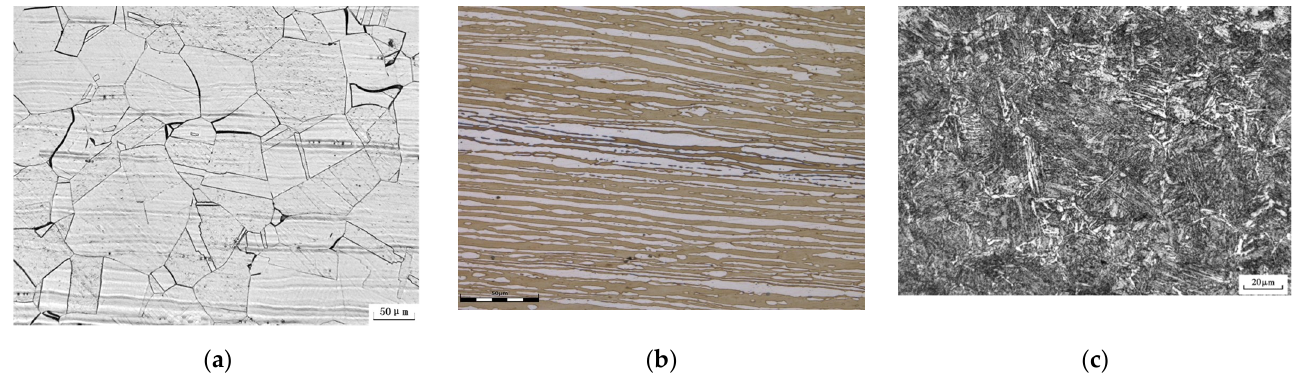
Figure 18. Typical microstructures of materials used in the oil and gas industry: ( a ) austenite stainless steel; ( b ) duplex stainless steel; ( c ) N80Q casing.